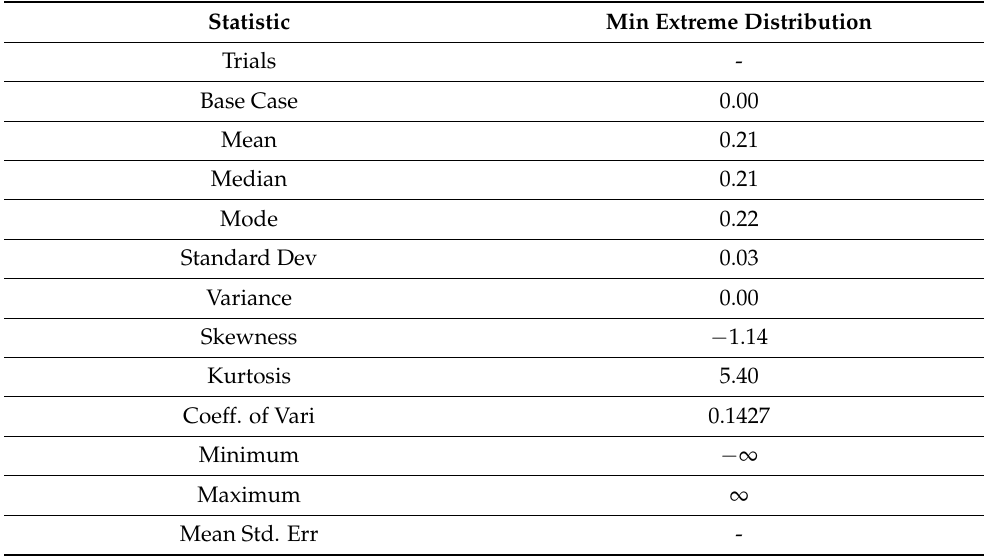
Figure 2. Probability distribution of accommodation facilities’ occupancy in Košice in 2003–2019. Table 2. Descriptive statistics of probability distribution of accommodation facilities in